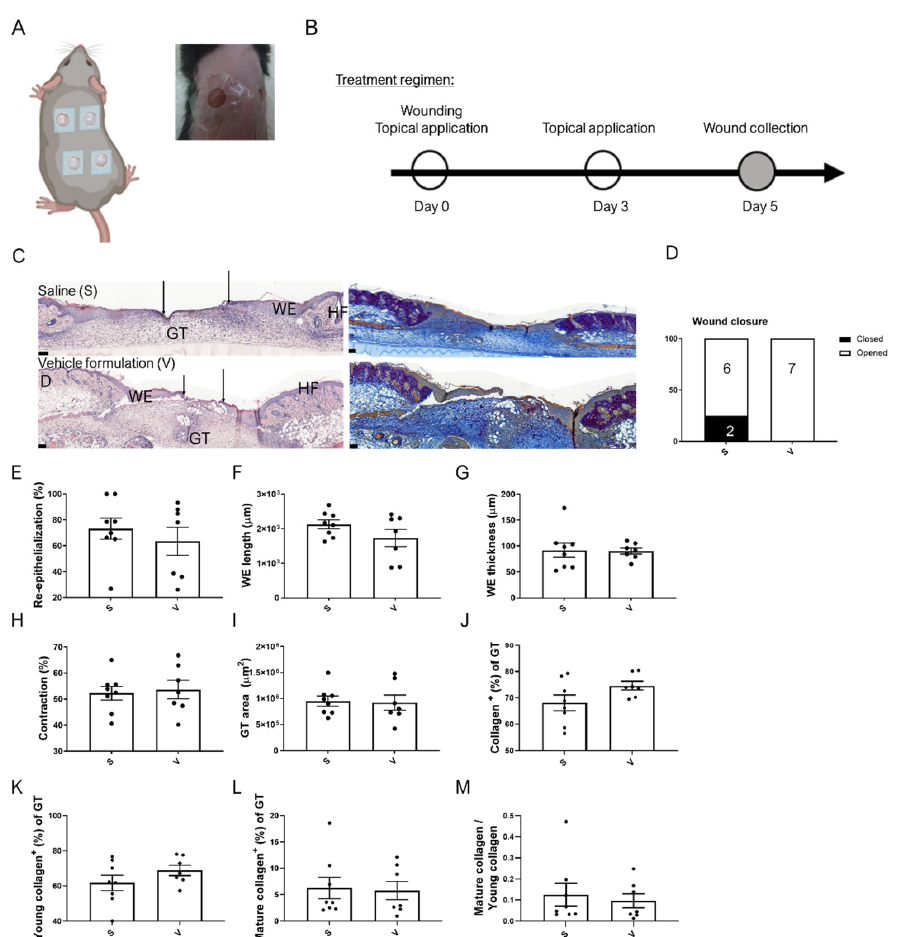
Figure 2. The liquid hydrogel formulation has no adverse effects on wound healing. ( A ) Scheme illustrating the topical wound treatment (left) and a representative topically treated wound covered with Tegaderm (right). The scheme was created using BioRender.com. ( B ) Treatment regimen for wound healing experiments. ( C ) Representative photomicrographs of hematoxylin/eosin (left)-and Herovici (right)-stained paraffin sections from 5-day wounds of healthy mice treated with saline or vehicle liquid hydrogel formulation. Magnification bars: 100 µm. D: Dermis, Es: Eschar, GT: Granulation tissue, HF: Hair follicle, WE: wound epidermis. Black arrows indicate the tips of the epithelial tongues. ( D ) Percentages of open (white bars) and closed (black bars) 5-day wounds based on histological sections. n = 8 (saline; S) or n = 7 (vehicle; V) wounds. ( E ) Percentage of wound re-epithelialization, including open and closed wounds. n = 7–8 wounds. Length ( F ) and average thickness (epidermis area/epidermis length) ( G ) of the wound epidermis (WE). n = 7–8 wounds. ( H ) Percentage of wound contraction based on the initial wound length (5 mm). n = 7–8 wounds. ( I ) Area of granulation tissue (GT). n = 7–8 wounds per treatment group. Percentage of collagen-positive GT area ( J ), percentage of young (blue) ( K ) or mature (purple) ( L ) collagen-positive GT area and ratio of mature (purple)-to-young collagen (blue) positive GT area ( M ) based on Herovici staining. n = 7–8 wounds. Bars indicate mean +/ − SEM.